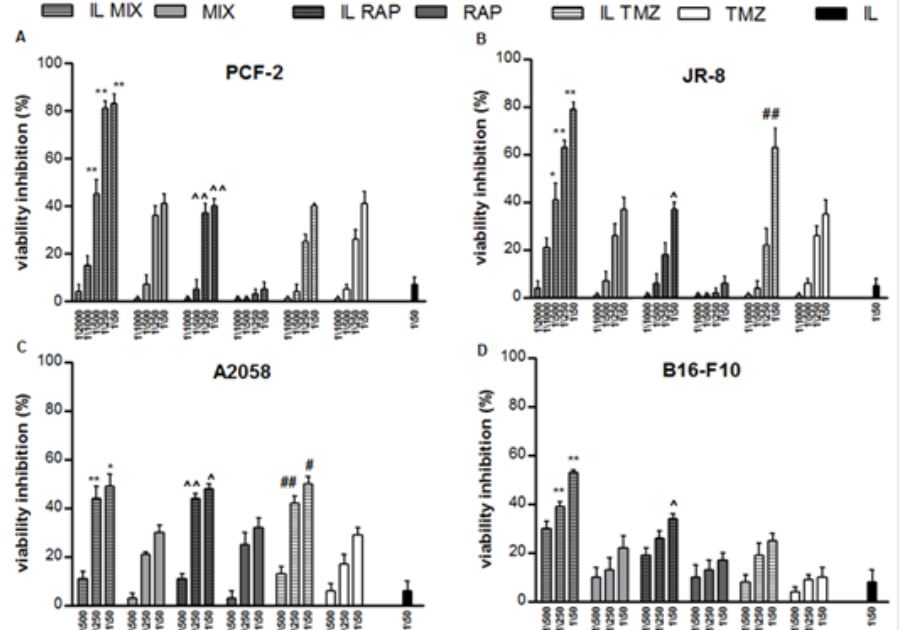
Figure 2. Cytotoxicity experiments towards melanoma cell lines; IL MIX vs. MIX * p < 0.05 ** p